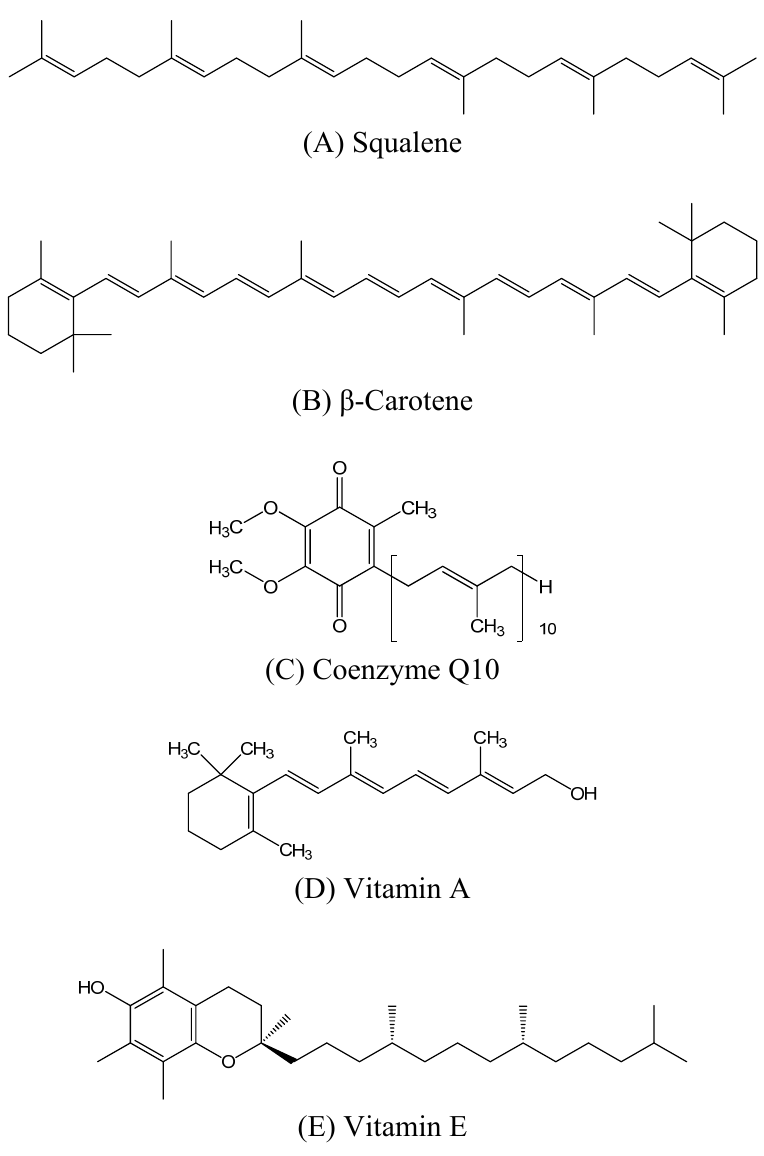
Figure 1. Chemical structures of (A) squalene, (B) β -carotene, (C) coenzyme Q10, and (D) vitamins A, (E) E, and (F) K 1